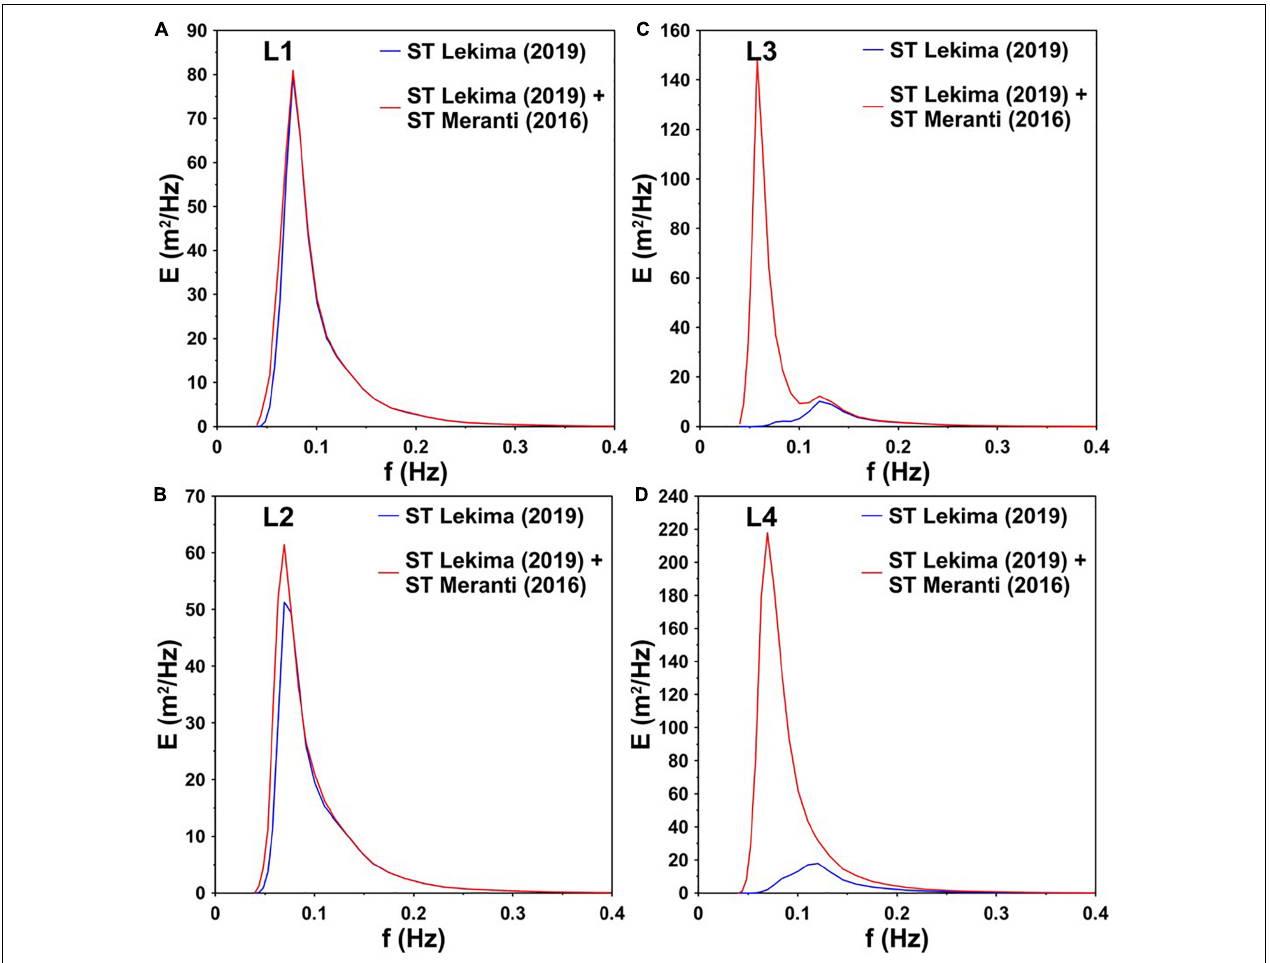
FIGURE 13 | Comparison of 1-D wave energy spectra time series generated by Super Typhoon Lekima in 2019 and designed binary typhoons Lekima (2019) and Meranti (2016) at (A) L1, (B) L2, (C) L3, and (D) four selected representative points at the time of the peak significant wave during single Super Typhoon Lekima